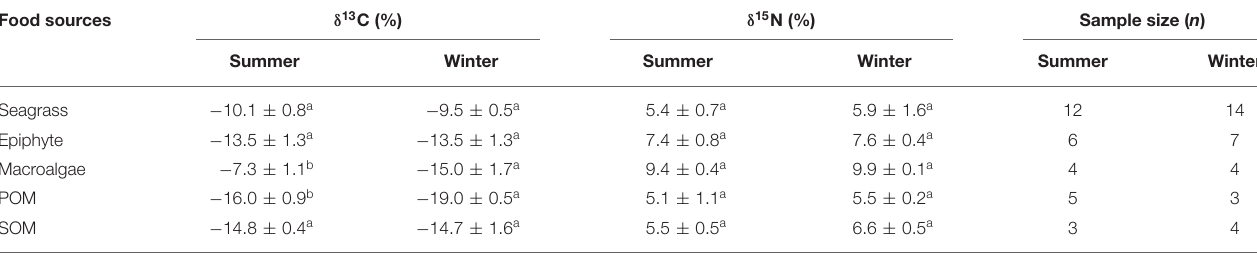
TABLE 2 | The δ 13 C, δ 15 N values and sample size (mean ± SD) of food sources in summer and winter in Xincun bay. Food